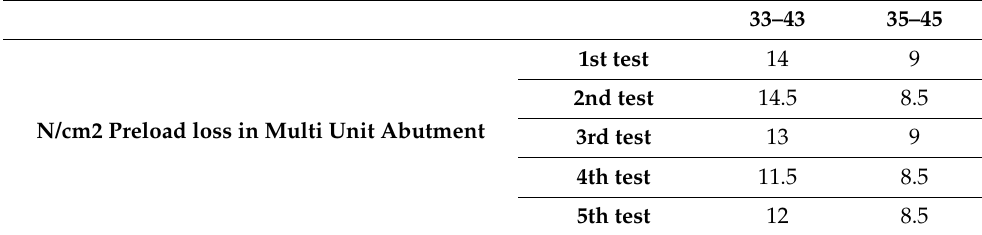
Table 2. Comparison between anterior and posterior placed M.U.A. in term of absolute preload